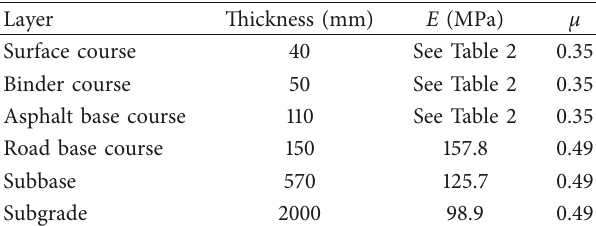
Table 6: Geometry and material properties of the pavement.